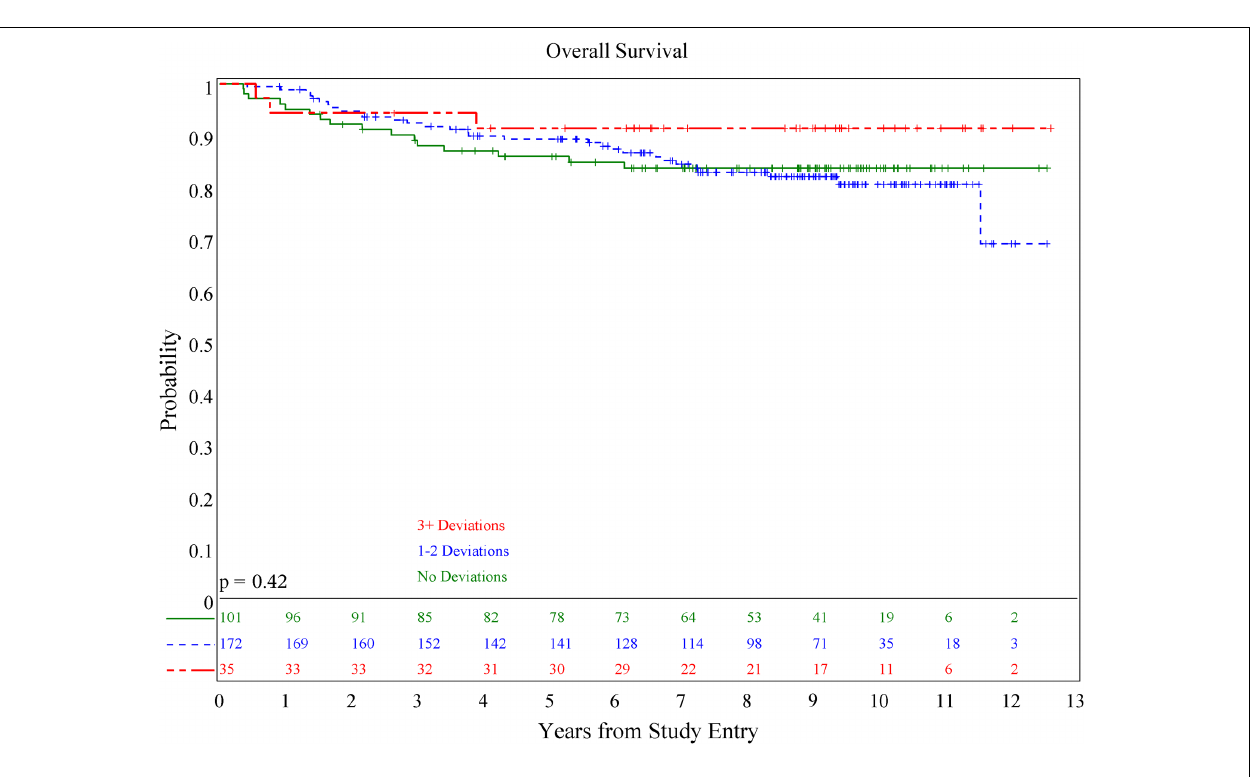
FIGURE 4 |Association of number of deviations and overall